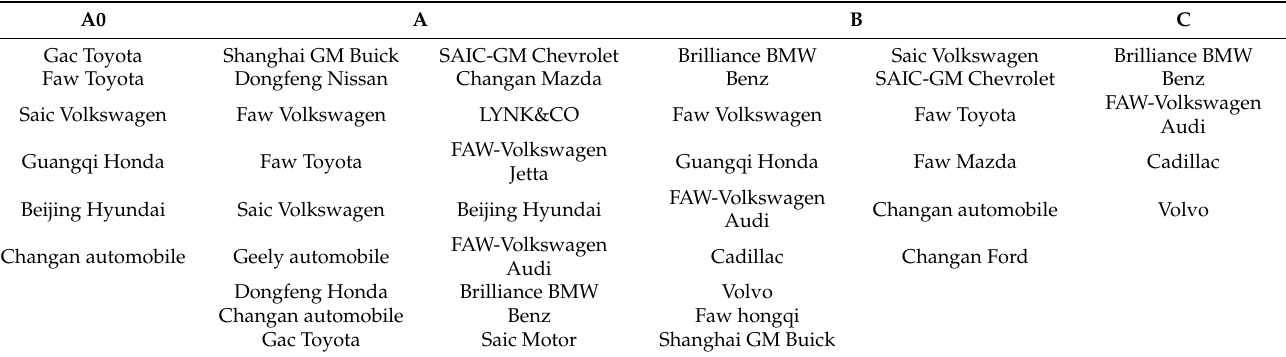
Table A3. Manufacturers participating in the auto production at each level.